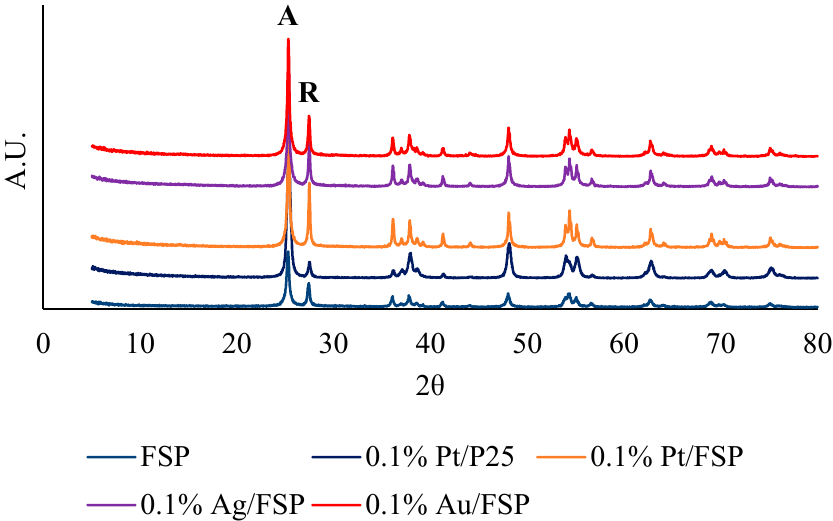
Figure 2. XRD spectra of selected photocatalysts, where “A” and “R” are, respectively, the reflections of the anatase and rutile forms.